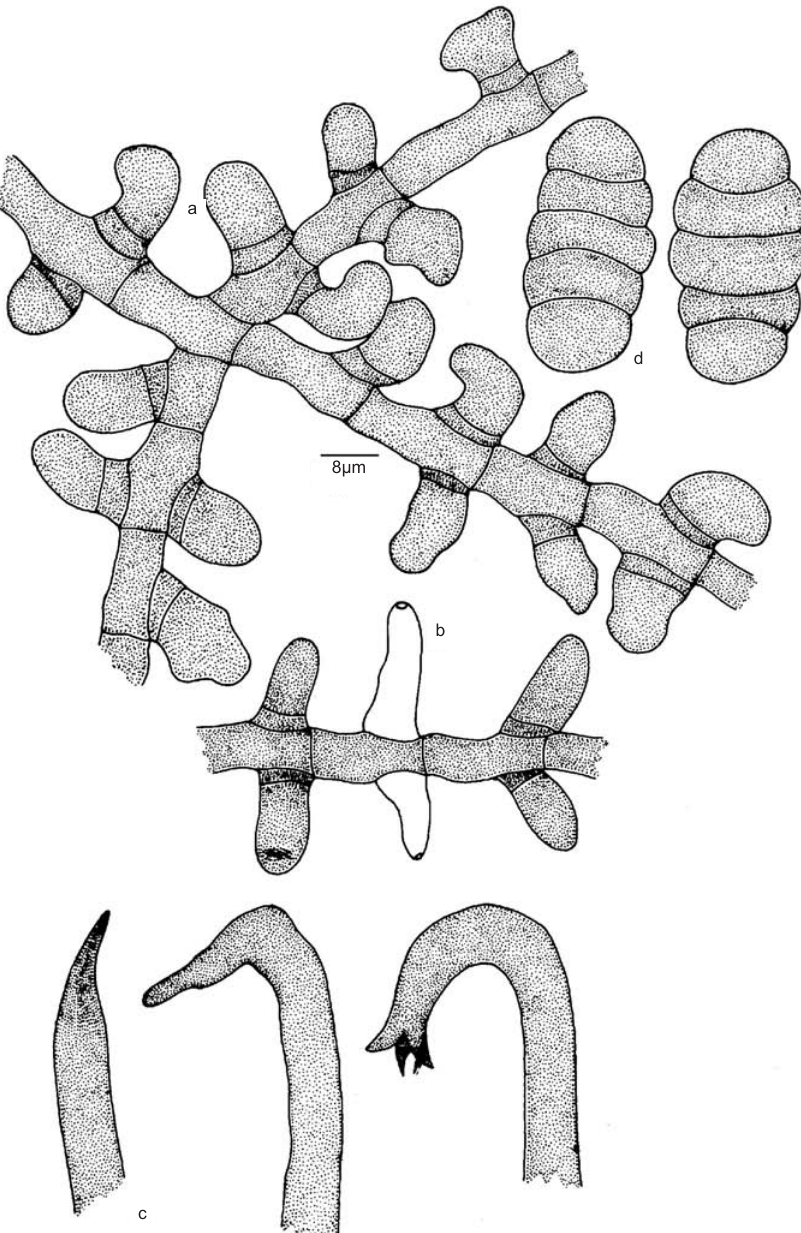
Figure 2. Meliola clausenigena sp. nov. a - Appressorium; b - Phialide; c - Apical portion of the mycelial setae; d -